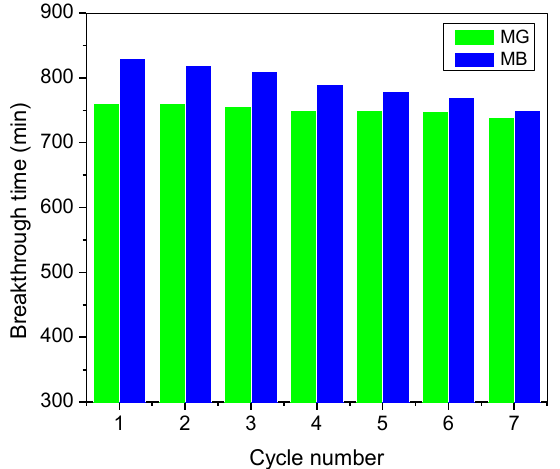
Figure 10. Regeneration performance of T-PAA at consecutive cycle in MG and MB binary dye system (pH: 9; 𝐶 0 : 50 mg/L; 𝑍 : 6 cm; 𝑄 : 3.0 mL/min).